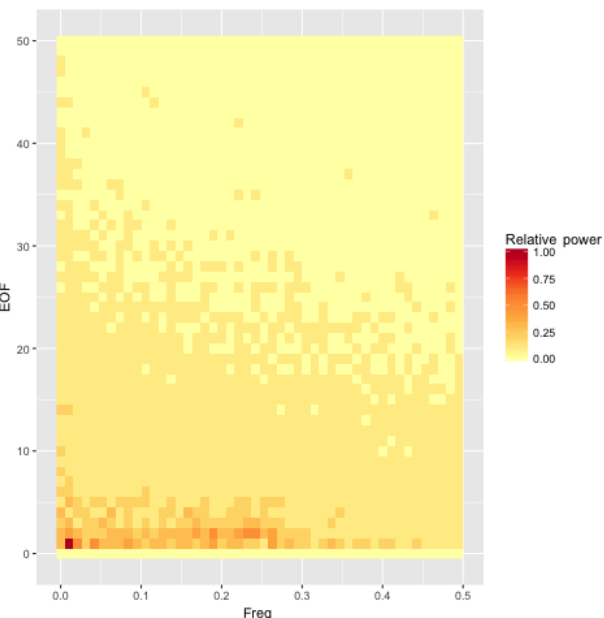
Figure 4. Heat map of power spectral density (PSD) for the first 50 EOFs. The trend of decreasing total power and more uniform spectral density continues for the remaining EOFs beyond EOF 50.